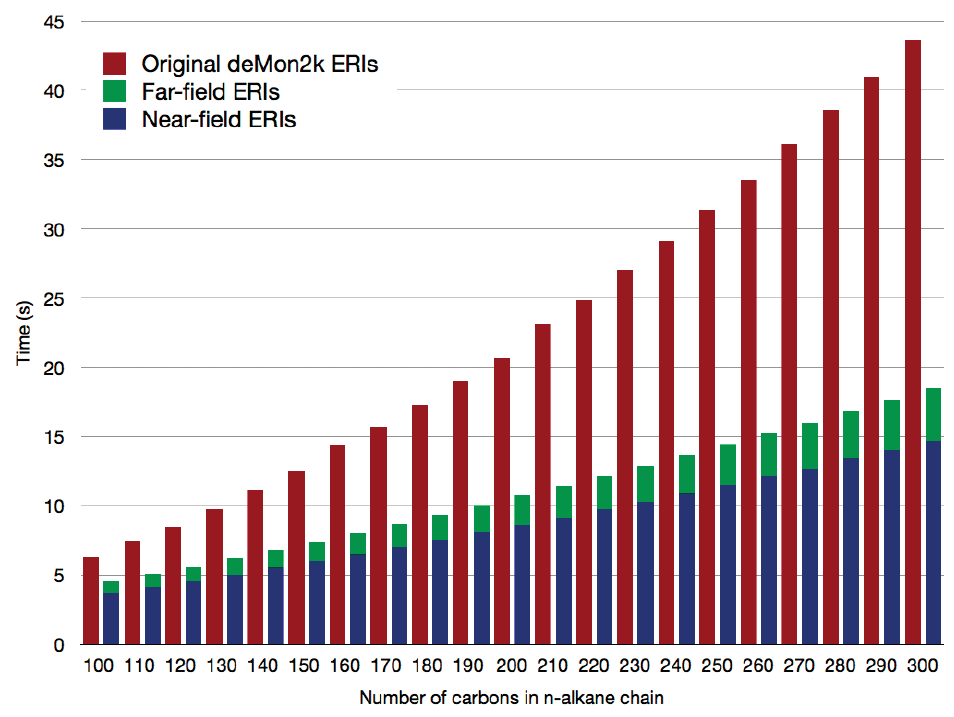
Figure 2. ERI calculation time per SCF cycle for selected n-alkane chains using the original deMon2k code (red bars) and the double asymptotic expansion (blue and green bars).